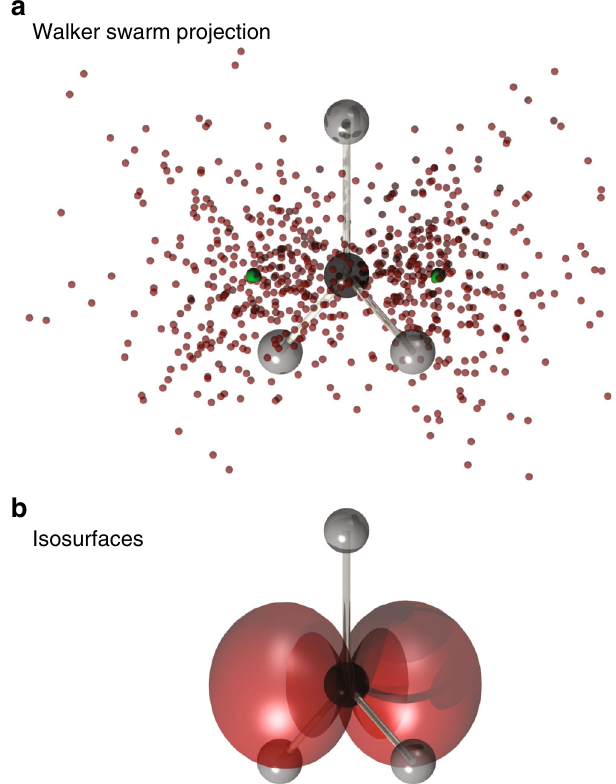
Fig. 2 Projections of the wavefunction tile for the methyl radical. a The projection of the walkers representing the wavefunction tile onto the coordinates of the unpaired electron of methyl radical. The green spheres represent the Voronoi sites of the two sub-tiles. b The isosurfaces generated by cross sections through the Voronoi sites in a